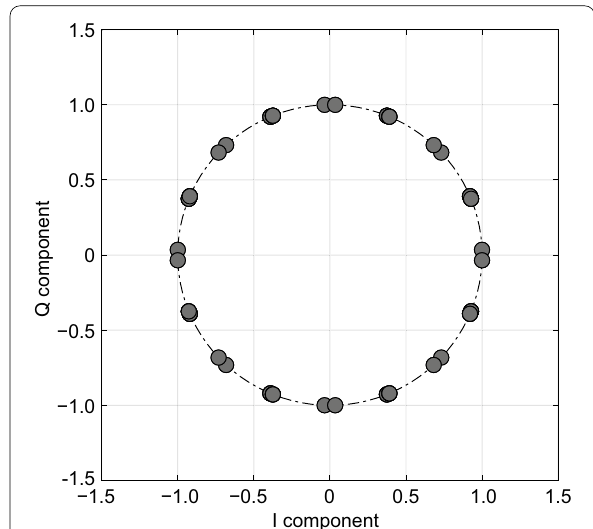
Fig. 3 Multiplexing modulation constellation of Type-III ACE-BOC